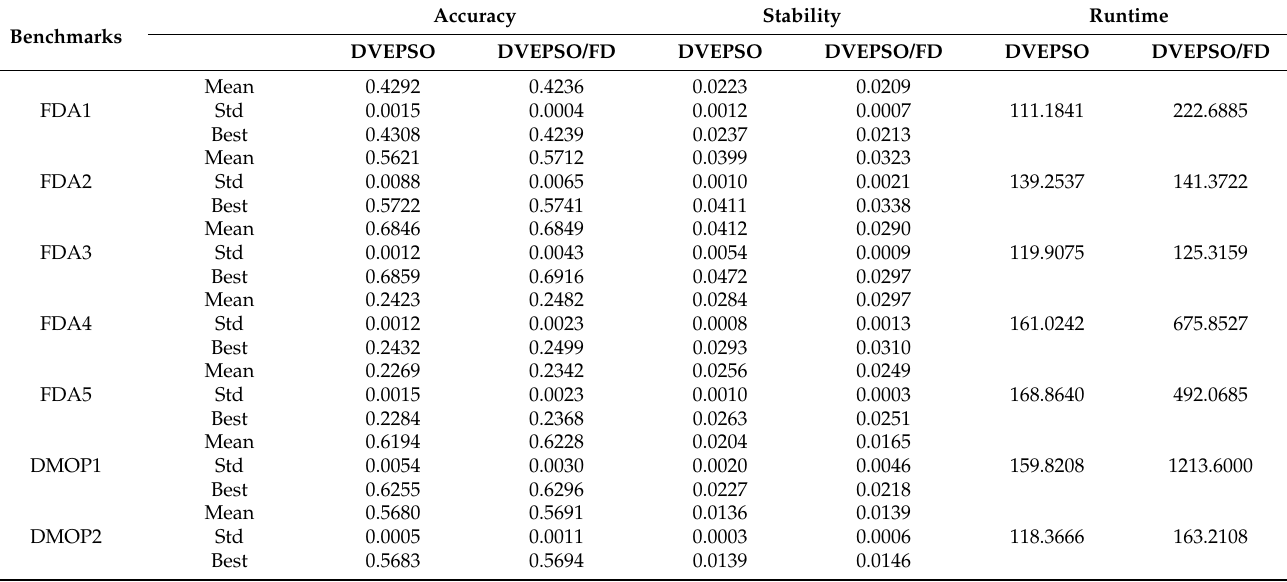
Table 5. The accuracy and stability metrics on